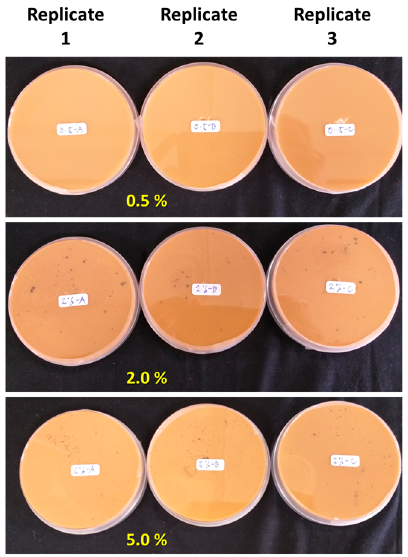
Figure 6. Reverse side of the Petri dishes containing PDA growth medium. The black spots visible at 2.0 and 5.0% were agglomerated SLNPs. 2.0 and 5.0% were agglomerated